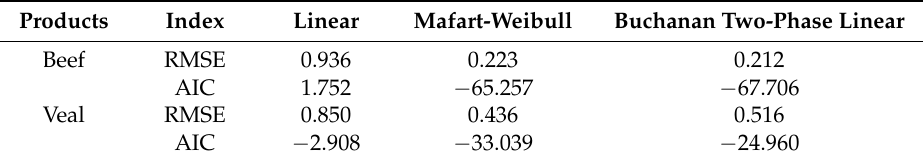
Table 5. Comparison of square root of mean of sum of squared errors (RMSE) and Akaike information criterion (AIC) value for the proposed survival models on the inactivation of E. coli O157:H7 in ground beef and veal patties after double pan-broiling at 177 ◦ C (350 ◦ F) for 0 to 360 s.